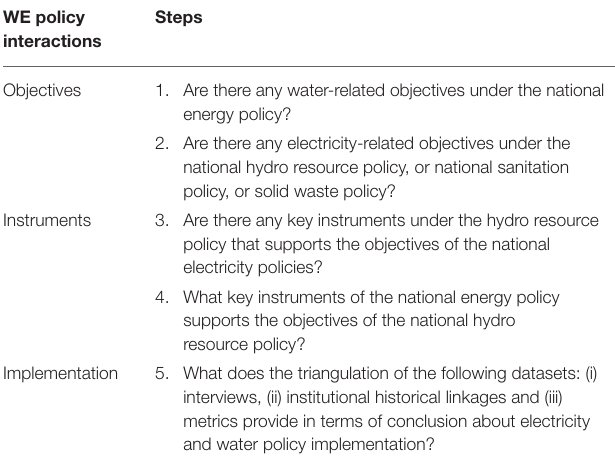
TABLE 3 | Steps to assess water and electricity policies